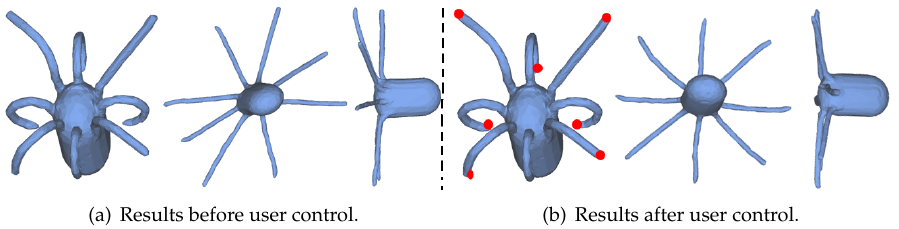
Figure 9. While the canonical form (( a )-middle) generated with our method for the Octopus model (( a )-left) is satisfactory, its tentacles are not in a plane from the other view(( a )-right). To improve it, we interactively select points at the end of its tentacles shown as red color in ( b )-left. The results shown with two views( ( b )-middle and ( b )-right), which are obtained by restricting the directions and lengths of the adjacent